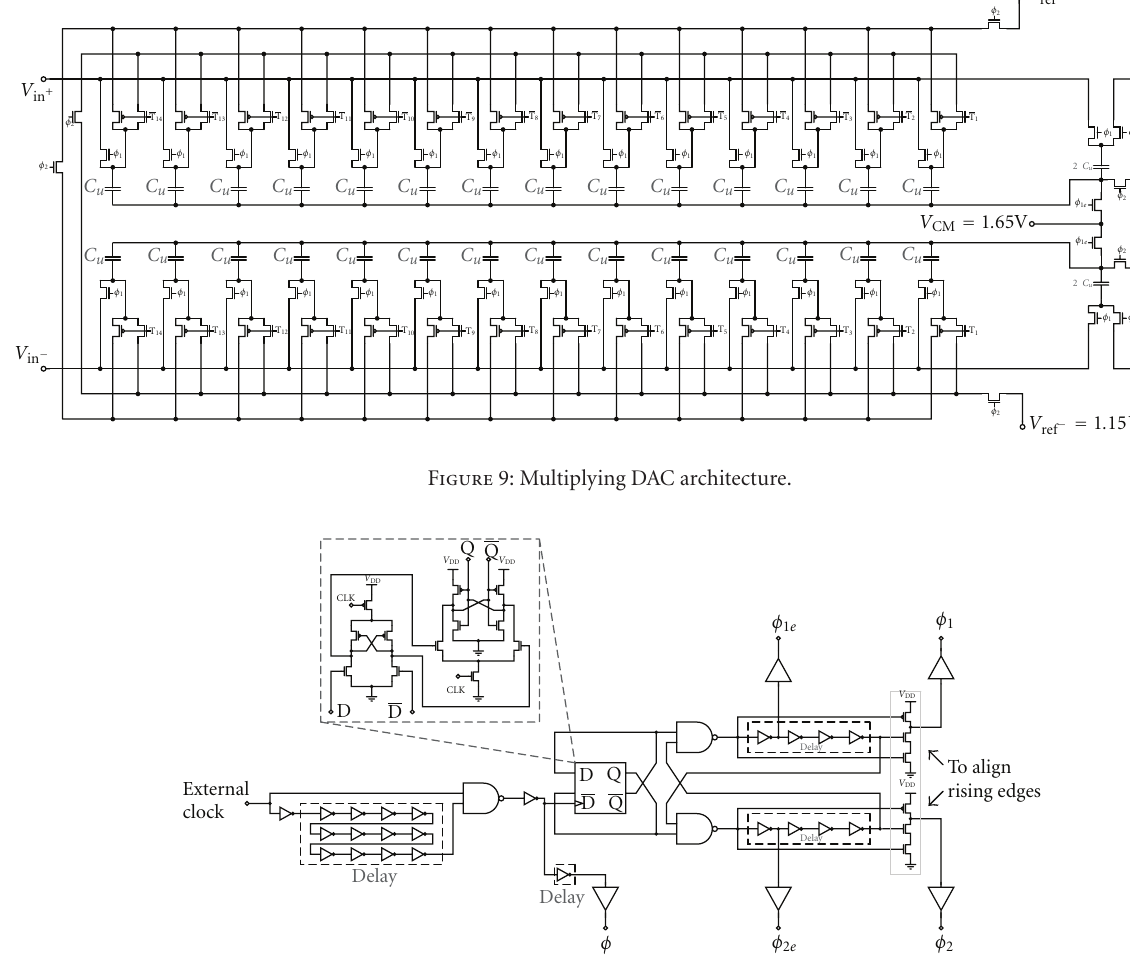
Figure 10: Clock phase